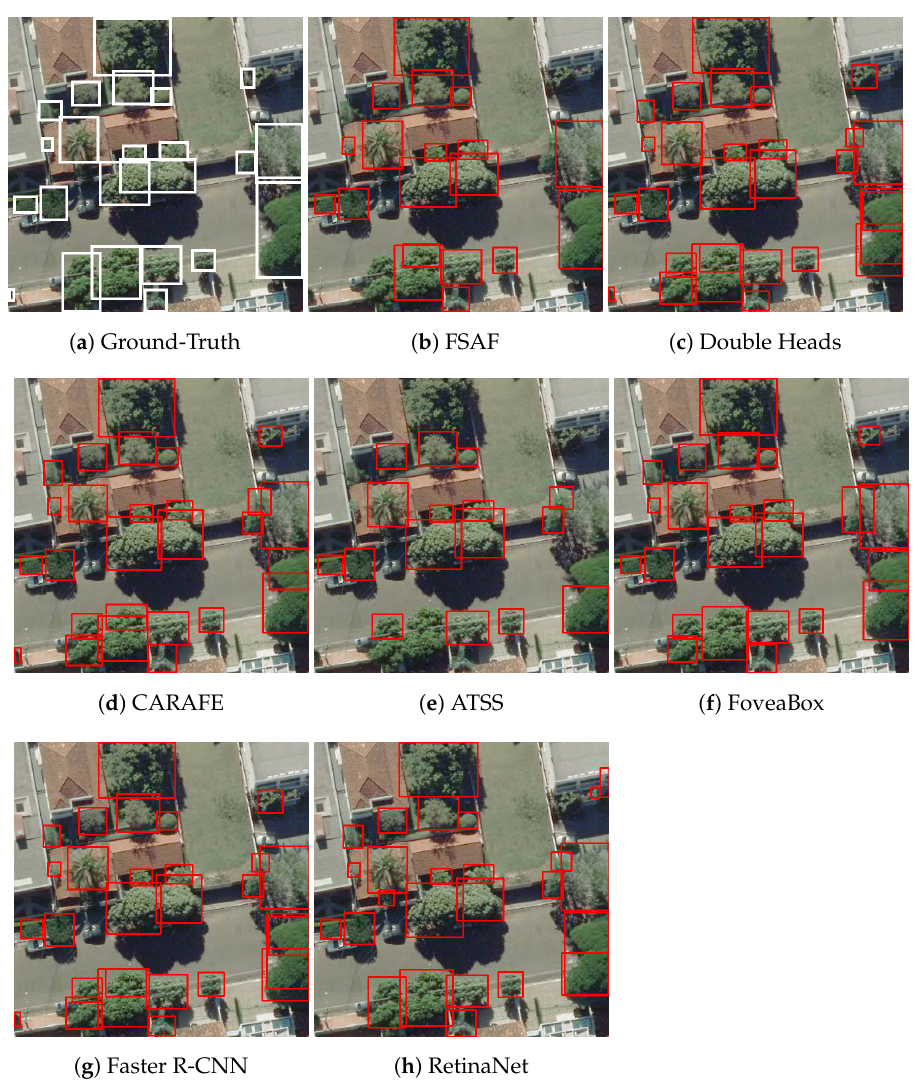
Figure 12. Tree detection with the top five methods, RetinaNet, and Faster R-CNN: performance with small and medium trees from several species.